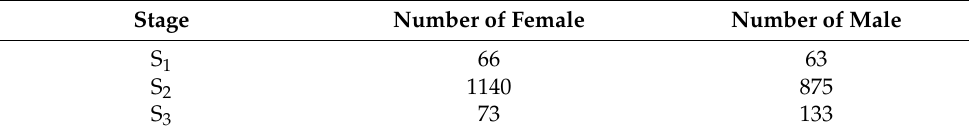
Table 1. Bone age dataset used in this